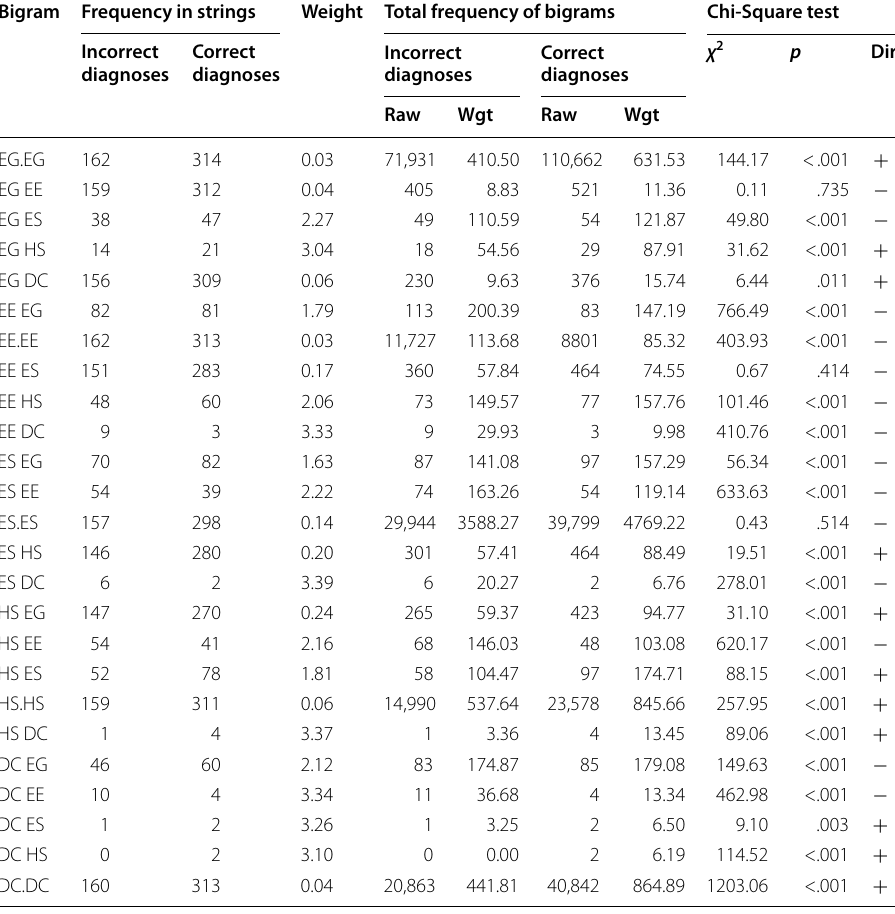
Table 2 Frequency of Occurrence of Bigrams in Incorrect and Correct Diagnoses Bigram Frequency in strings